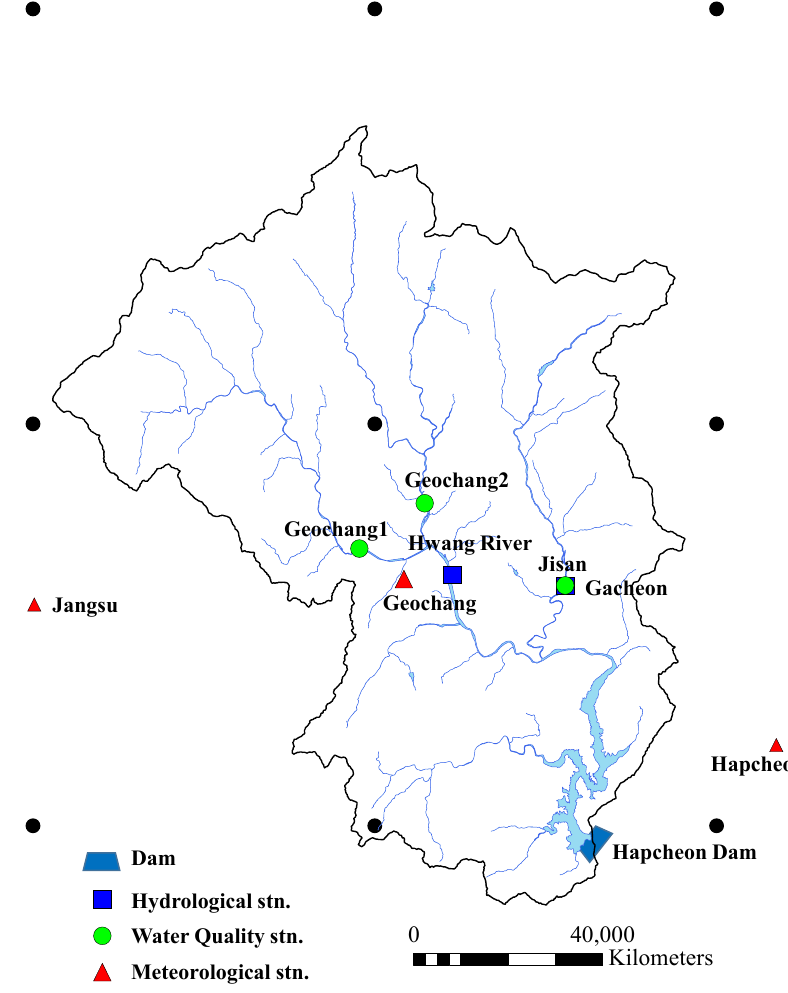
Figure 2. Gauging stations and RCM grids with 27-km resolution for Hapcheon Dam